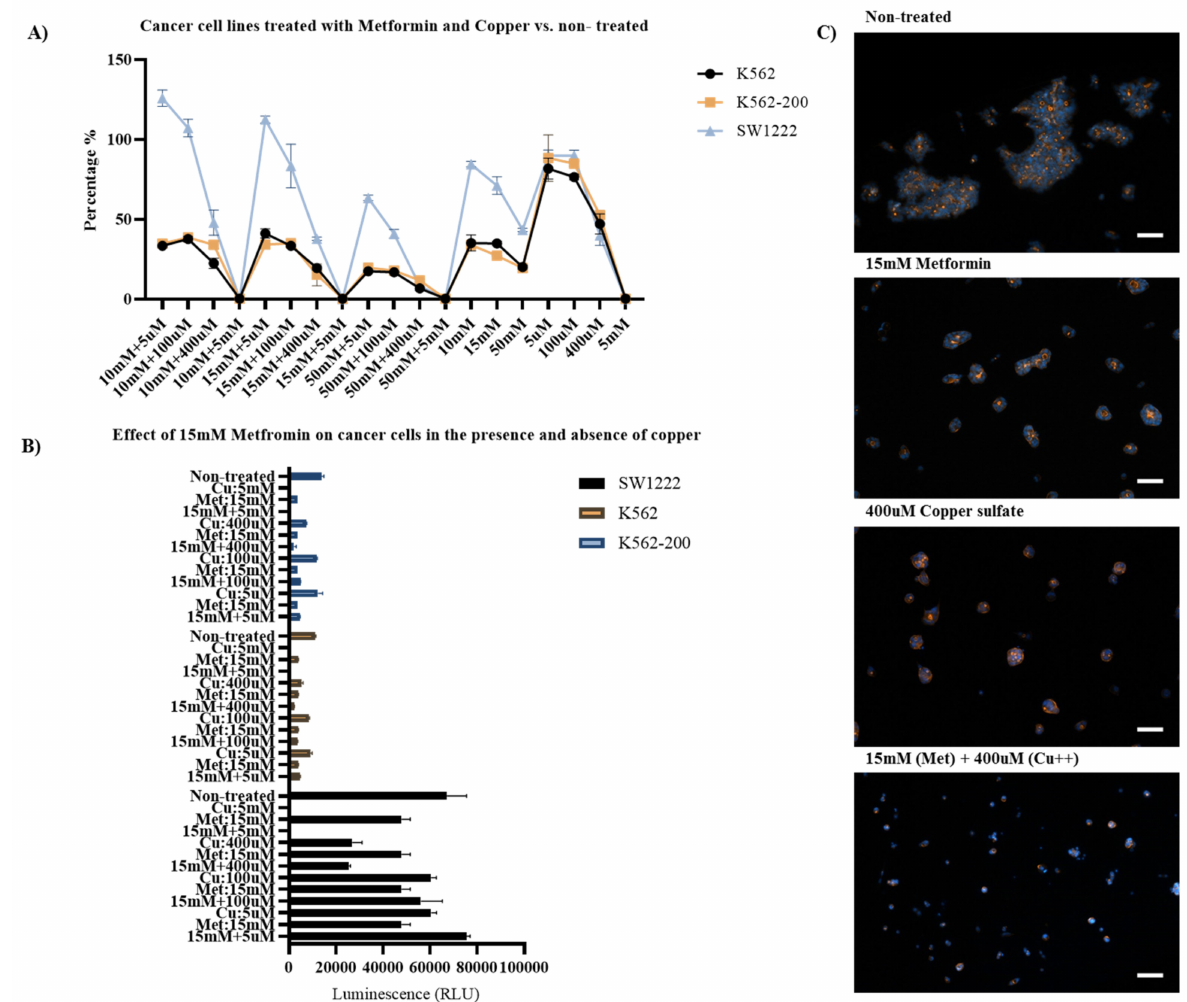
Figure 9. Effects of copper (II) on the anticancer properties of metformin. ( A ) ATP luminescence readings from SW1222, K562, and K562-200 cell lines treated with metformin and copper, normalized against untreated cells. ( B ) Comparison between the effects of either metformin, copper sulfate, or metformin and copper sulfate combined. ( C ) Fluorescent images of SW1222 cells showing the effect of 15 mM metformin, 400 µ M copper sulfate, or both combined. (scale bar 100 µ